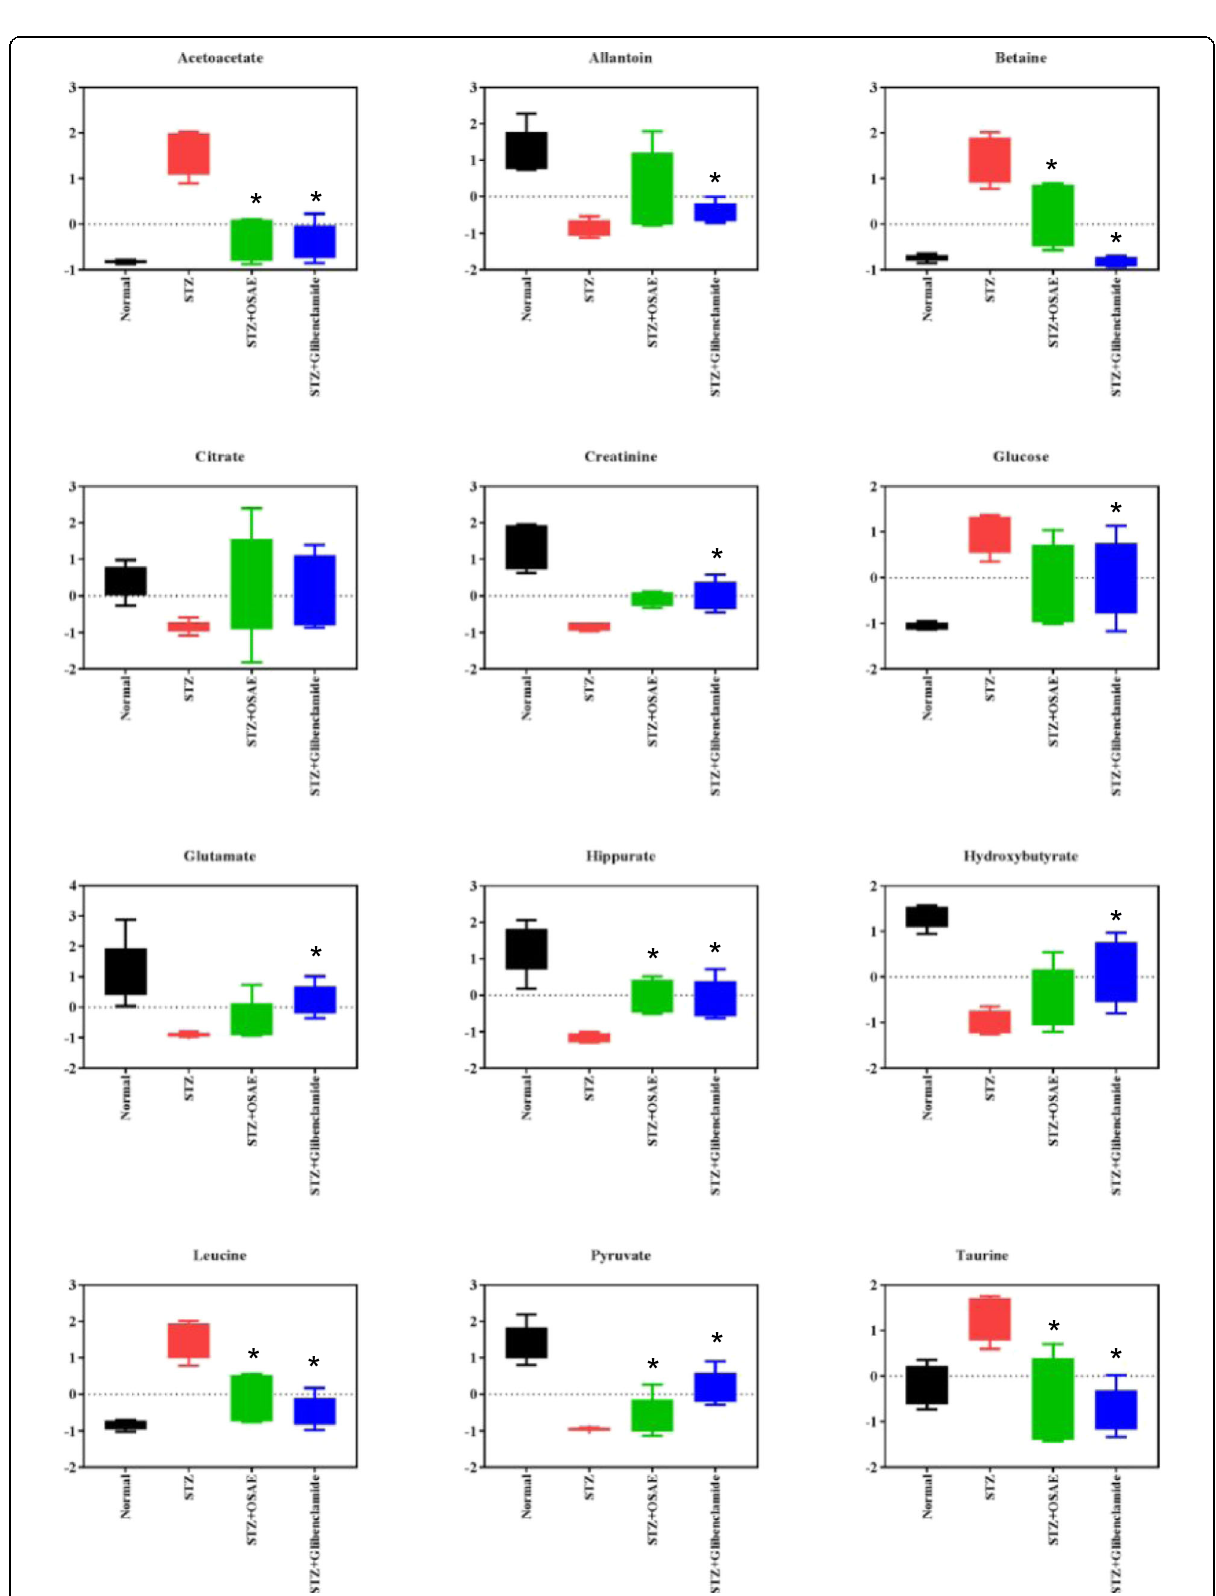
Fig. 6 The box plots of the relative quantities of the significant biomarkers in the urine samples of normal, diabetic, D-A and D-G rat urine